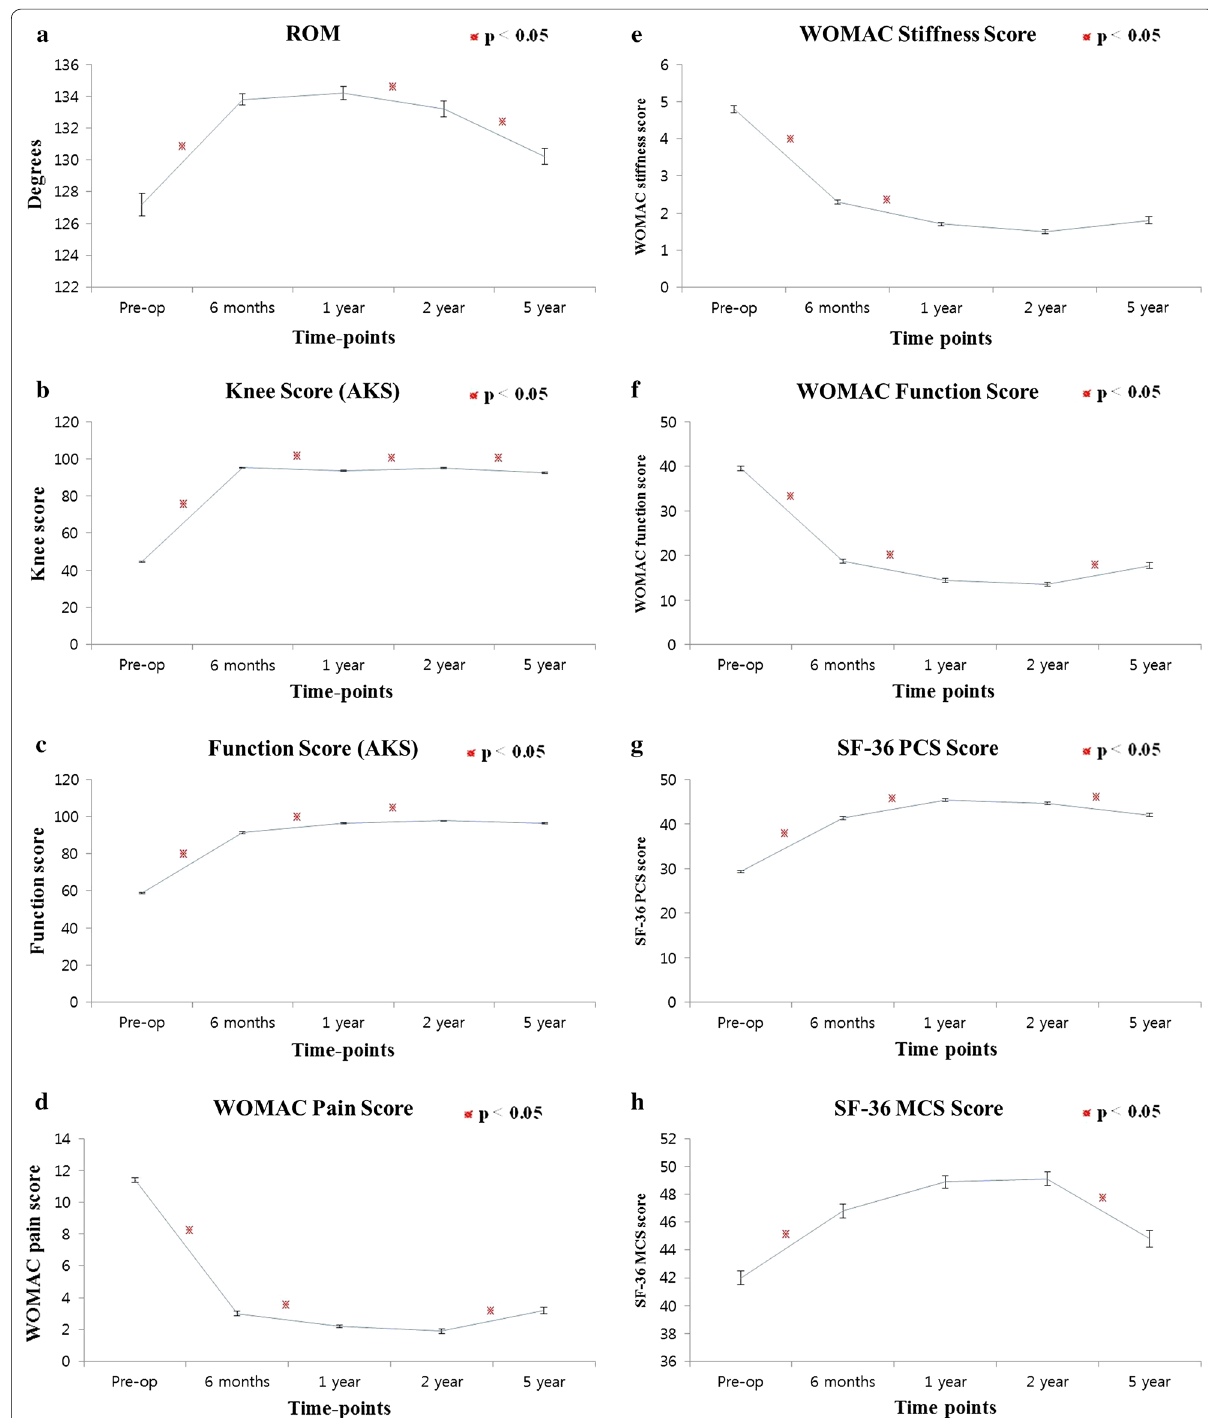
Fig. 2 Line diagrams depicting the various outcome parameters over 5 years (error bars depict standard deviation): a ROM, b AKS knee score, c AKS function score; d WOMAC pain score, e WOMAC stiffness score, f WOMAC function score, g SF-36 PCS score, and h SF-36 MCS